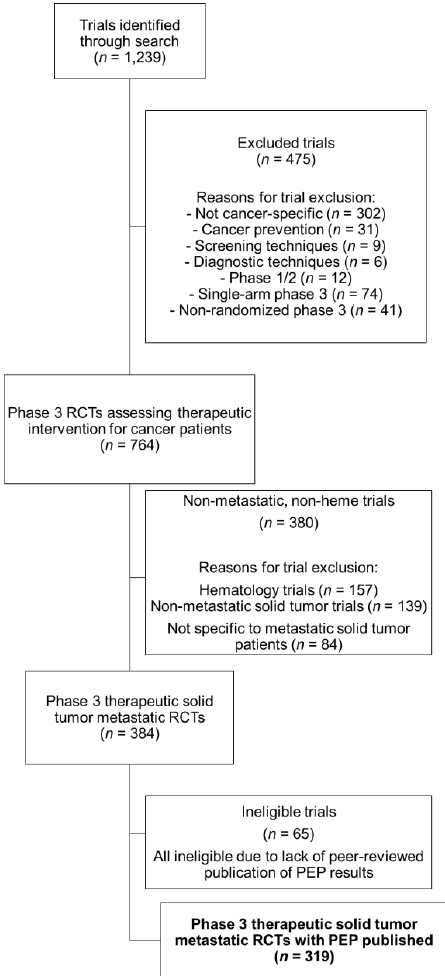
Figure 1. Consort diagram showing the selection criteria for phase three randomized control trials of metastatic solid tumor patients, with publications of their primary endpoints ultimately included in our analysis.